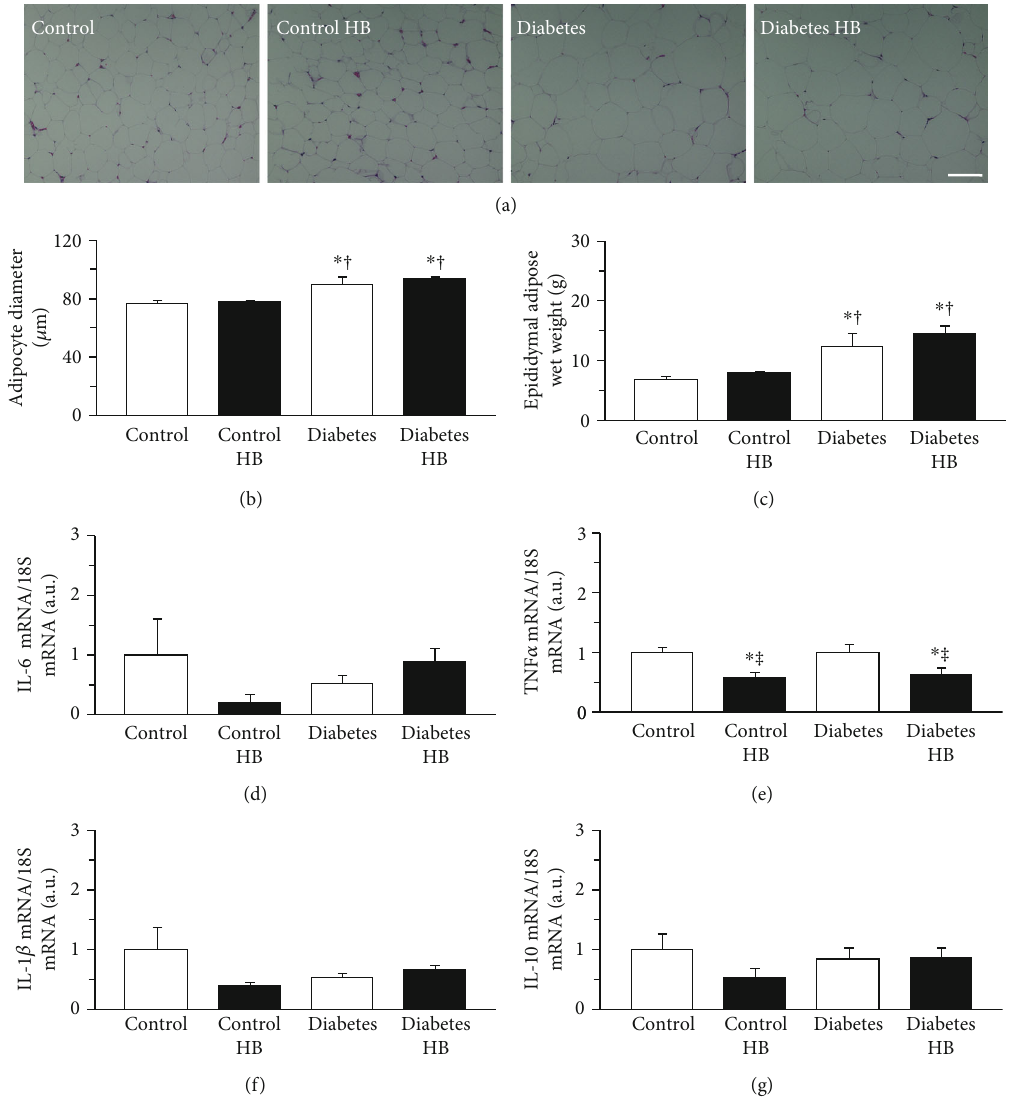
Figure 2: Adipocyte size, adipose tissue mass, and cytokine expression in adipose tissue. Representative sections of epididymal adipose tissue stained with hematoxylin and eosin (a), adipocyte diameter (b), wet weight of adipose tissue (c), expression levels of IL-6 mRNA (d), TNF α mRNA (e), IL-1 β mRNA (f), and IL-10 mRNA (g). Control: nontreated control group; Control HB: control treated with the hyperbaric normoxia group; Diabetes: nontreated diabetes group; Diabetes HB: diabetes treated with the hyperbaric normoxia group. Bar = 100 μ m . Values are means ± standard deviation . IL-6, TNF α , IL-1 β , and IL-10 mRNA expression levels were calculated as fold changes relative to the Control group. ∗ , † , ‡ Signi fi cantly di ff erent from the Control, Control HB, and Diabetes groups, p < 0 : 05 ,